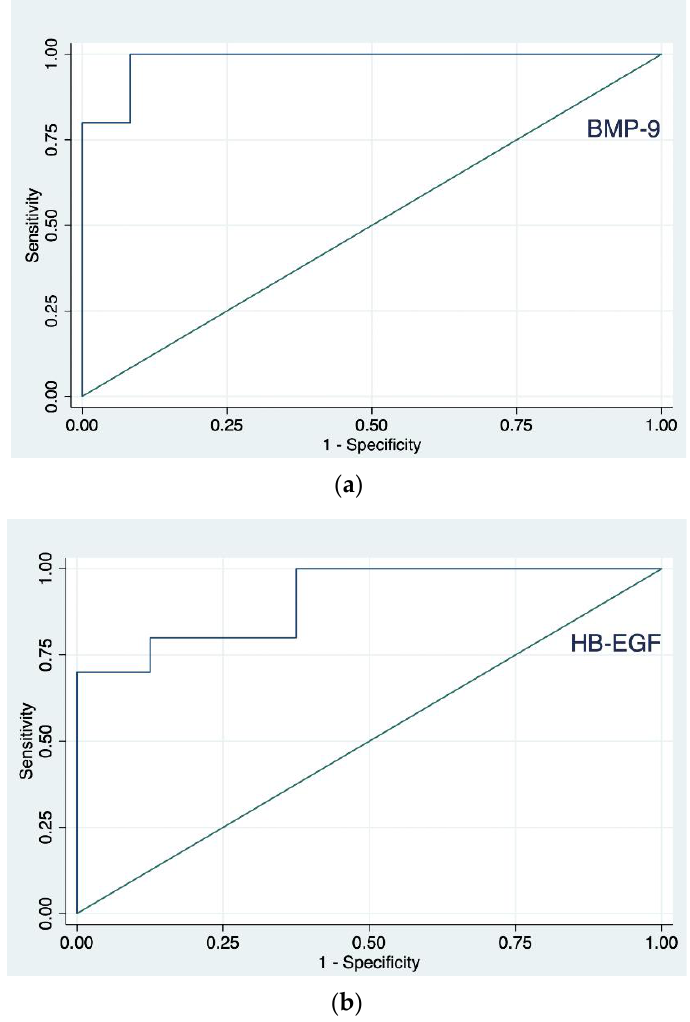
Figure 3. Receiver operating characteristic (ROC) curve for bone morphogenetic protein-9 (BMP-9) values obtained from nonalcoholic steatohepatitis (NASH)/nonalcoholic fatty liver disease (NAFLD) participants, area under the ROC curve (AUC) 0.98 ( a ), and heparin-binding EGF-like growth factor (HB-EGF) values obtained from hepatitis C virus (HCV) participants, area under the ROC curve (AUC) 0.89 ( b ).